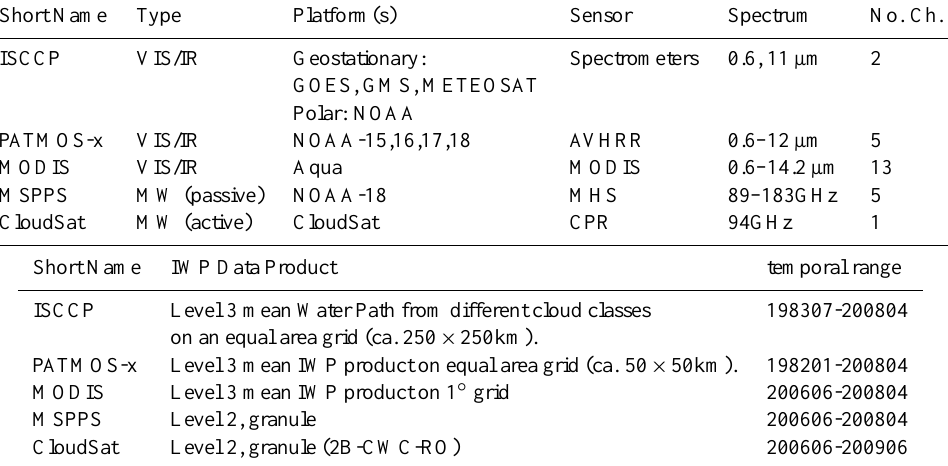
Table 2. Satellite datasets. The first part of the table contains the short name of the satellite dataset used in this study, the on-board instrument, and the number of channels in the radiance spectrum used for the retrieval. The second part shows the type of IWP product and the temporal range used in this study. MODIS pertains to IWP data from the Aqua satellite only and MSPPS pertains to data from NOAA18